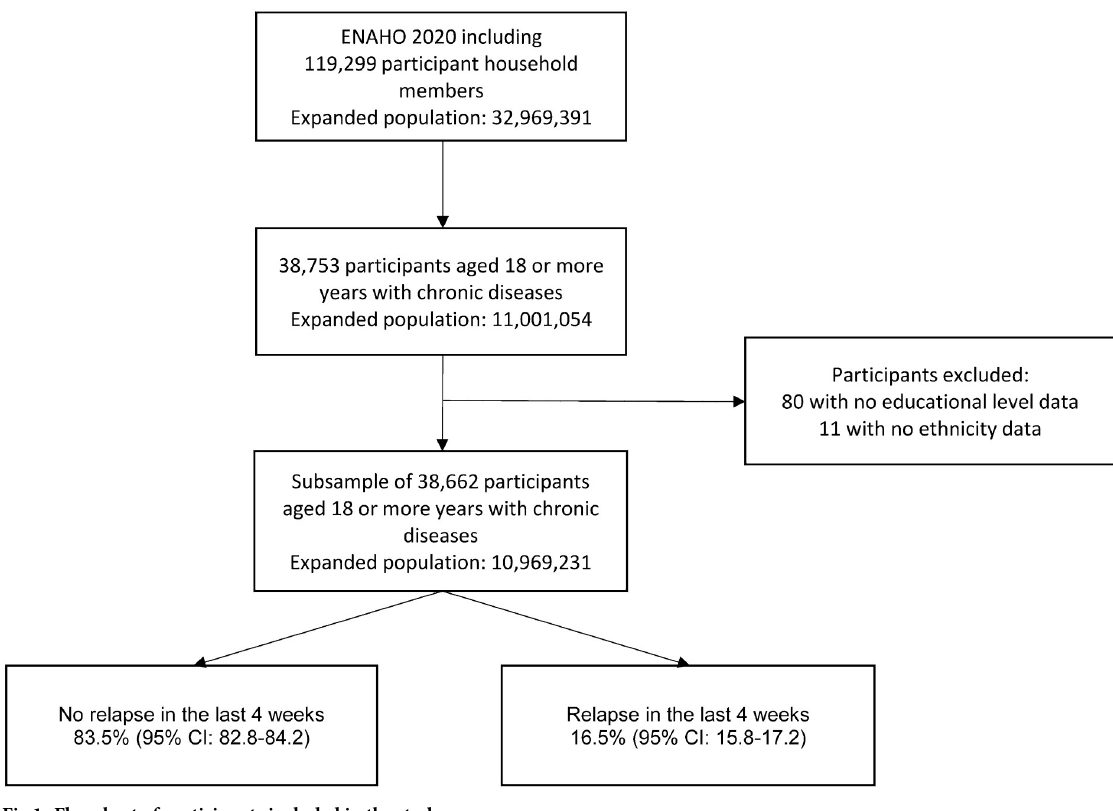
Fig 1. Flowchart of participants included in the